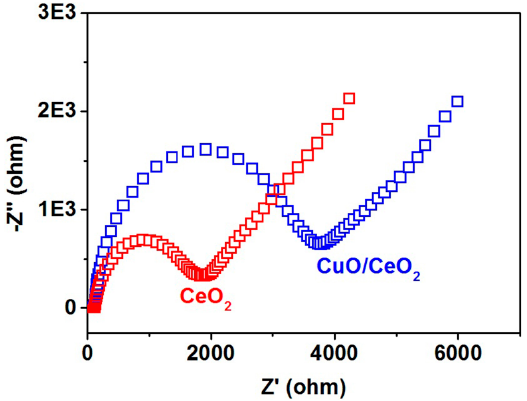
Figure 4. Nyquist impedance plots for CeO 2 /indium ‐ tin oxide (ITO) and CuO/CeO 2 /ITO electrodes recorded in 0.1 M KCl solution containing 1 mM Fe[(CN) 6 ] 3 − /4 − (1:1).